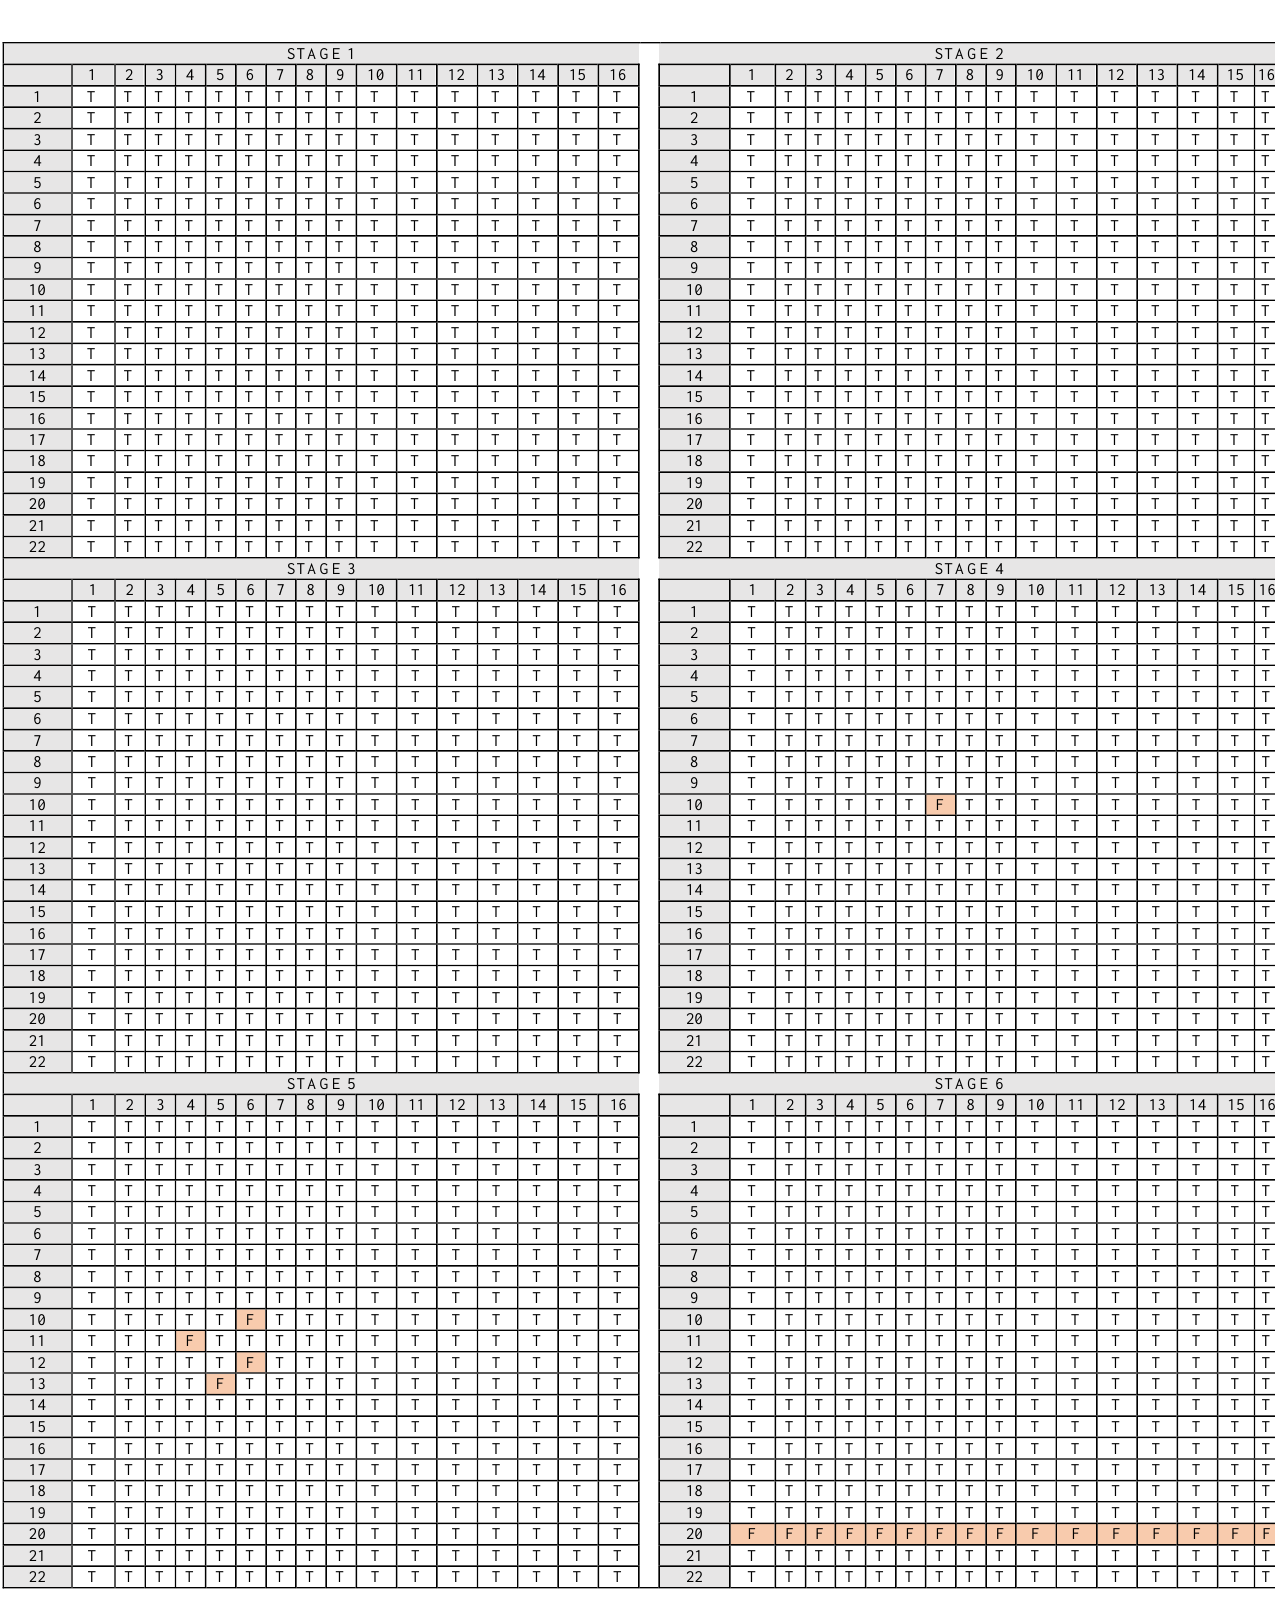
Figure 8. Policy differences. False (F) results are marked in orange. The 4 main variables were evaluated: the minimum value of the initial storage, spill- age and deficit volumes, and the average energy. The results are given in Table 2.